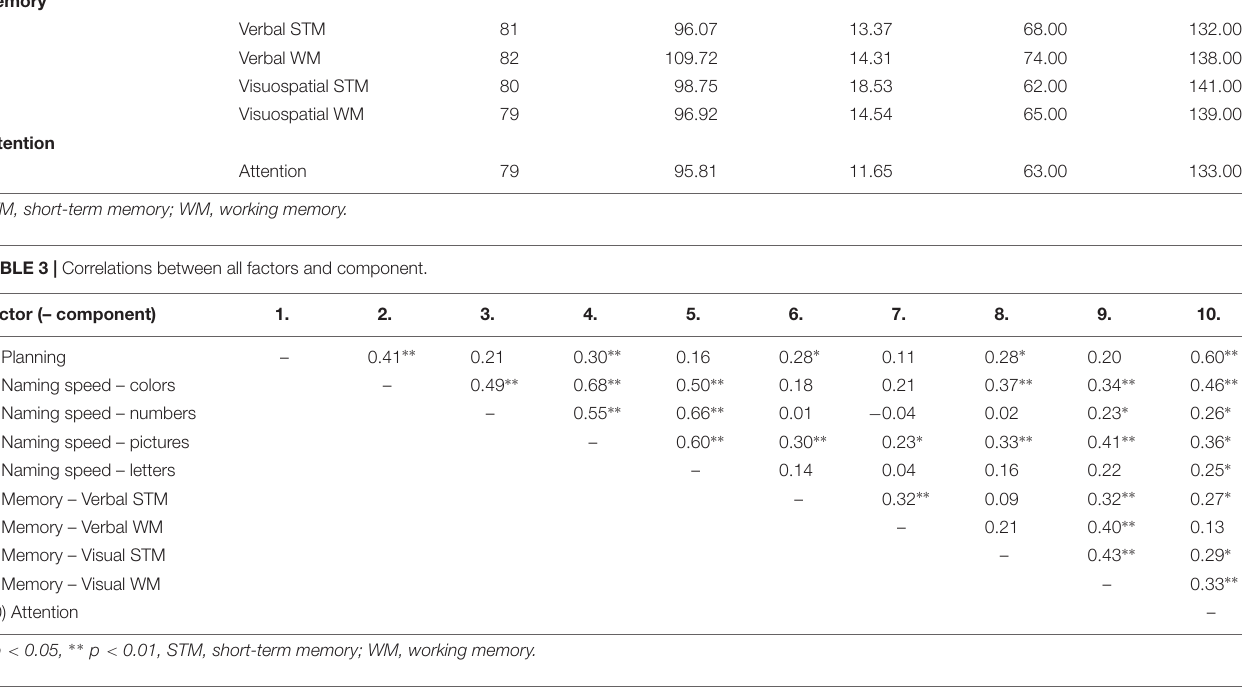
TABLE 4 | Numbers and percentages of students with deficits for each factor and component.